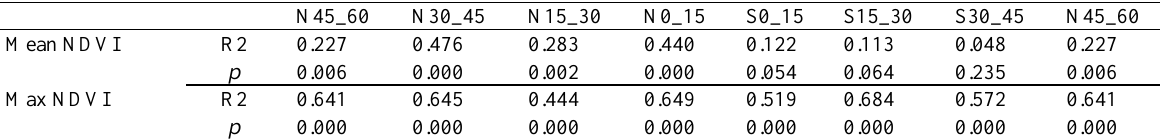
Table S3. The Statistic report of annual mean and maximum NDVI across the geographic latitude zones with a 150 interval.